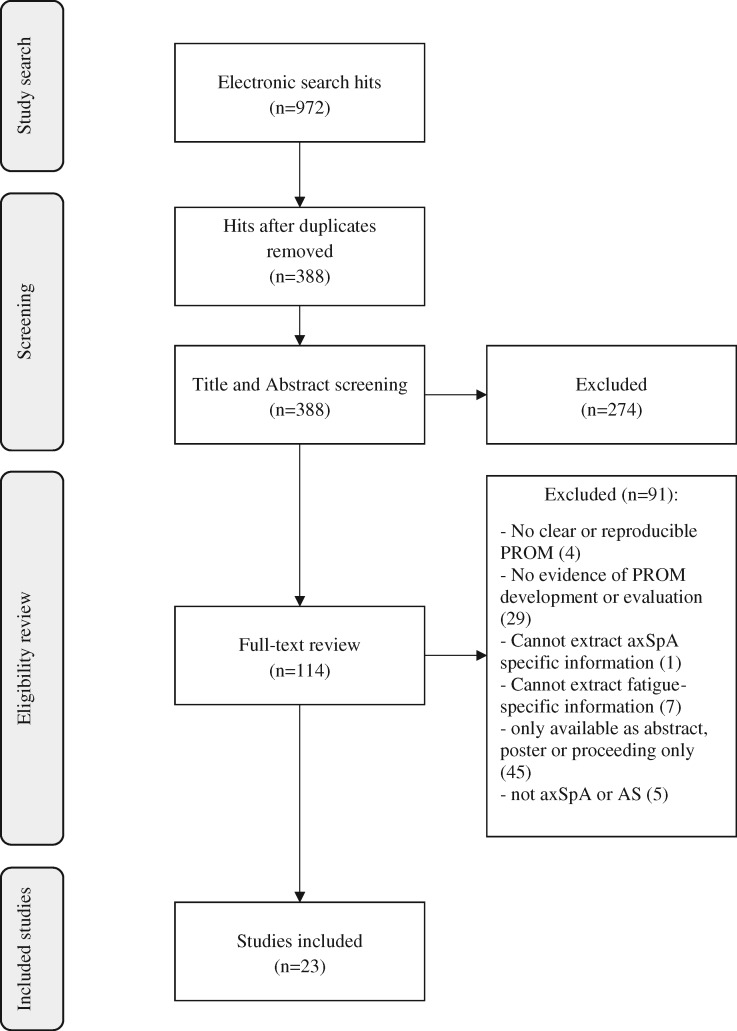
PRISMA flow-chart of study inclusion